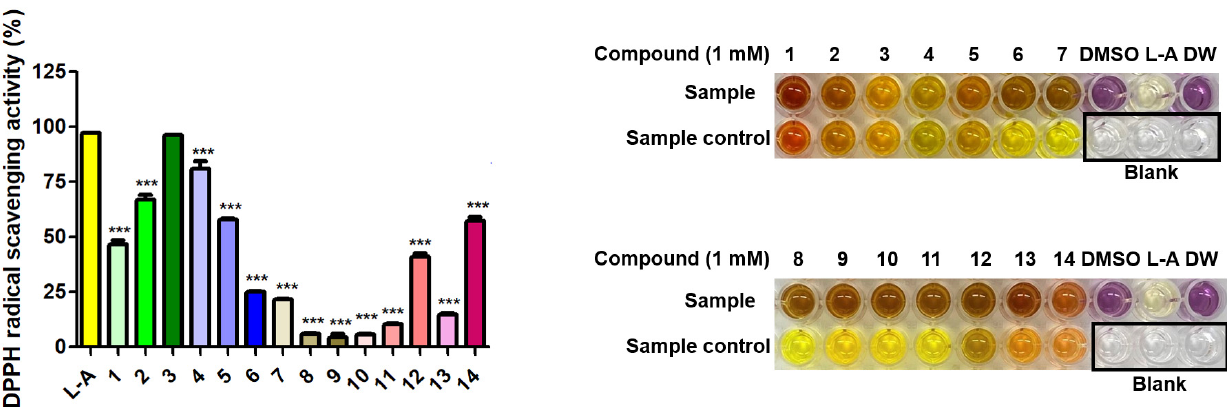
13 of 25 Figure 9. The ABTS cation radical scavenging effects of ( Z )-BPT derivatives 1 – 14 . Test samples 1 – 14 and Trolox, a positive control, were evaluated at a concentration of 100 µM. Asterisks (***) represent a significant difference between the ( Z )-BPT derivatives and Trolox, and results are expressed as the mean ± standard error of three different experiments. *** p < 0.001 and ** p < 0.01. 2.10. DPPH Radical Scavenging Effects of (Z)-BPT Derivatives 1 – 14 The 2,2-diphenyl-1-picrylhydrazyl (DPPH) radical scavenging capacity of the ( Z )-BPT derivatives (1 mM) was investigated using L -ascorbic acid (1 mM, vitamin C) as a positive control. Figure 10 shows the radical scavenging outcomes. A total of 7 of the 14 ( Z )-BPT derivatives (1–5, 12, and 14) showed moderate to strong DPPH radical scavenging activity compared with L -ascorbic acid. While ( Z )-BPT derivatives 8–11, with no hydroxyl substitu- ents on the β -phenyl ring of the PUSC template, did not demonstrate any appreciable DPPH radical scavenging activity, those with hydroxyl substituents typically demonstrated mod- erate to strong radical scavenging activity. L -Ascorbic acid scavenged 97.1% of the DPPH radical, whereas ( Z )-BPT derivative 1 with a 4-hydroxyl substituent on the β -phenyl ring scavenged 46.5% of the DPPH radical. Interestingly, when a 3-bromo substituent was in- serted into the β -phenyl ring of 1, the radical scavenging activity decreased to 14.8% (deriv- ative 13), but when two bromo substituents were introduced at positions three and five of the β -phenyl ring of 1, the radical scavenging activity increased to 57.3% (derivative 14). The strongest radical scavenging activity was observed in derivative 3 with a β -3,4-dihydroxy-